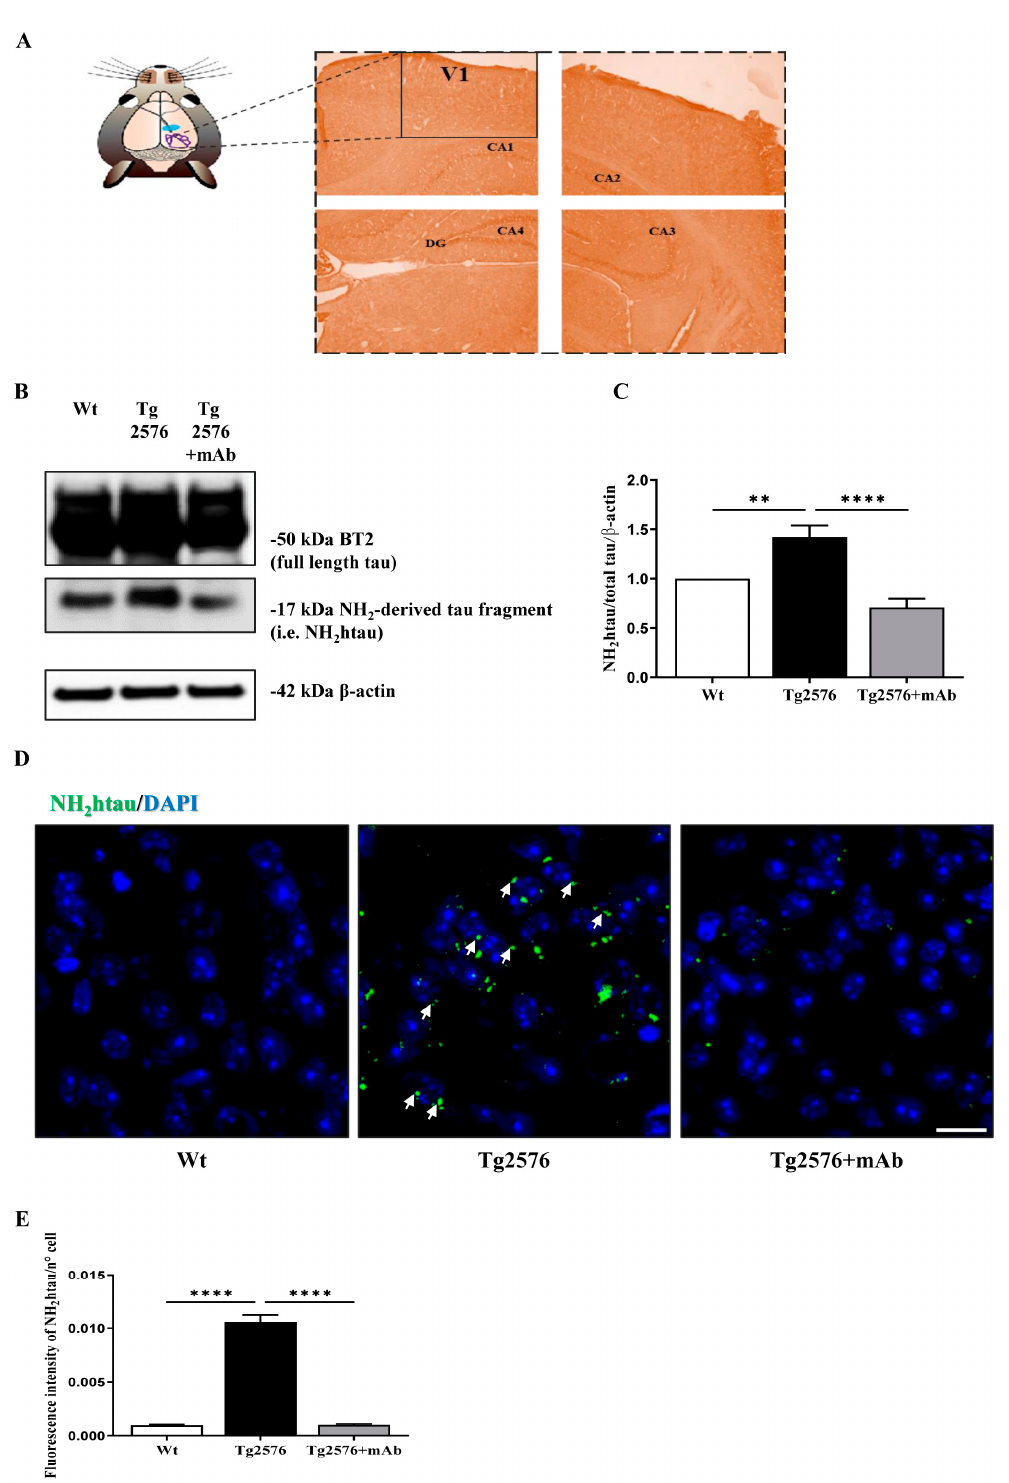
Figure 1. The neurotoxic 20 − 22 kDa tau fragment (NH 2 htau) peptide accumulates in the primary visual cortex (V1) of Tg2576 AD mice and it is successfully immunoneutralized following i.v. delivery of 12A12mAb. ( A ) Representative image of coronal brain slices showing the primary visual cortex (V1, box) of a mouse brain stained with Haematoxylin and Eosin and examined with a light electric microscope at 4 × . V1 Scale bar = 50 µ m. ( B ) Representative images of SDS-PAGE western blotting analysis (n = 8 animals per each group, 4 males and 4 females for each experimental condition) carried out on protein homogenates of the primary visual cortex (V1) from animals of three